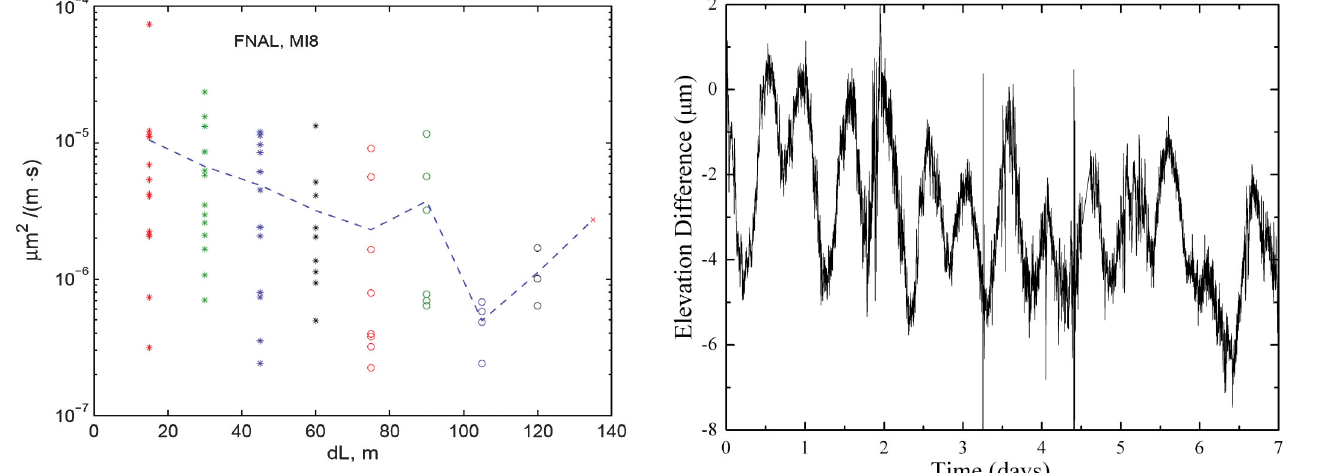
FIG. 36. One week record of elevation difference of two neighbor focusing magnets in the Tevatron tunnel as measured by HLS (starts midnight February 7, 2004; Ref. [30]).